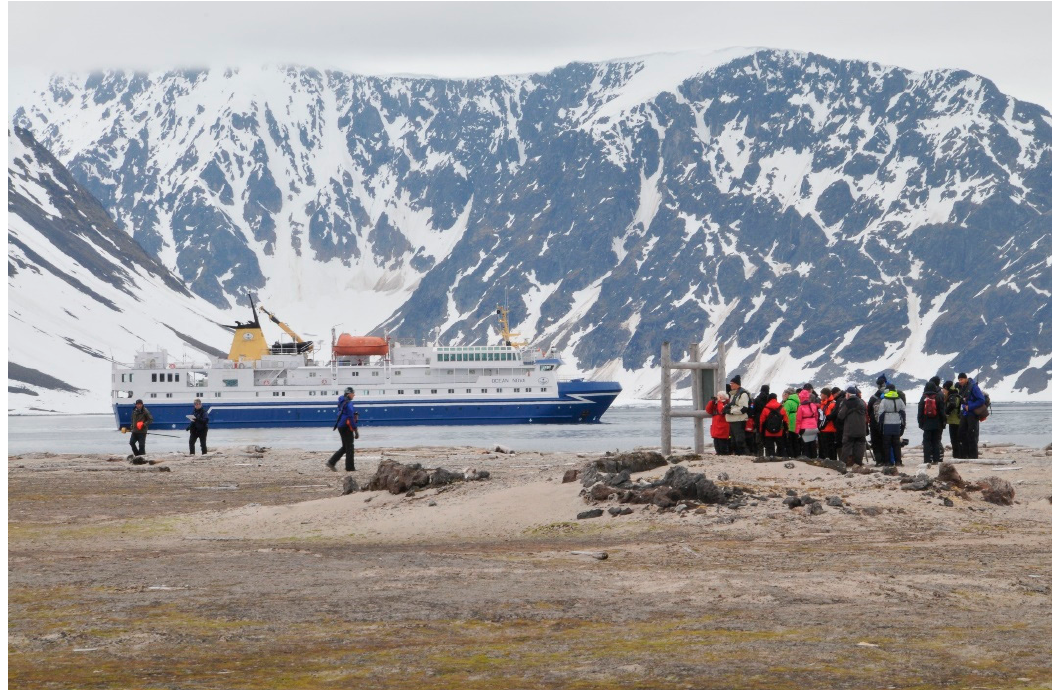
Figure 4. Cruise ‐ ship tourists visiting Smeerenburg. © Elin Rose Myrvoll 2014. Figure 4. Cruise-ship tourists visiting Smeerenburg. © Elin Rose Myrvoll